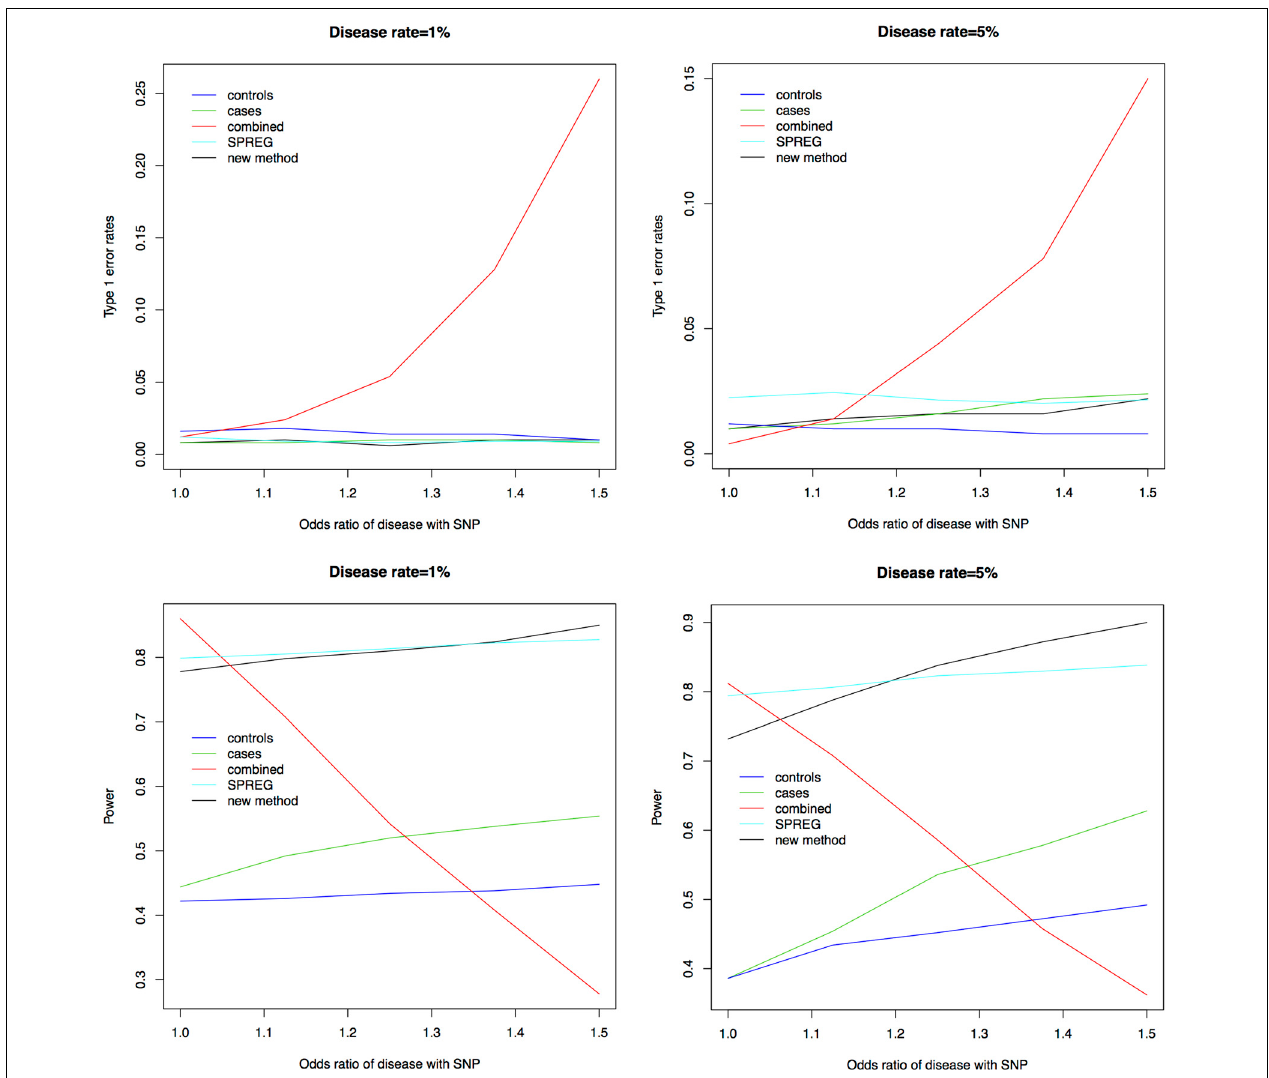
FIGURE 1 | Type 1 error rates and power for a disease rate of 1% and 5%. As seen in the plots above the new method using proportional odds logistic regression maintains the type 1 error rate.